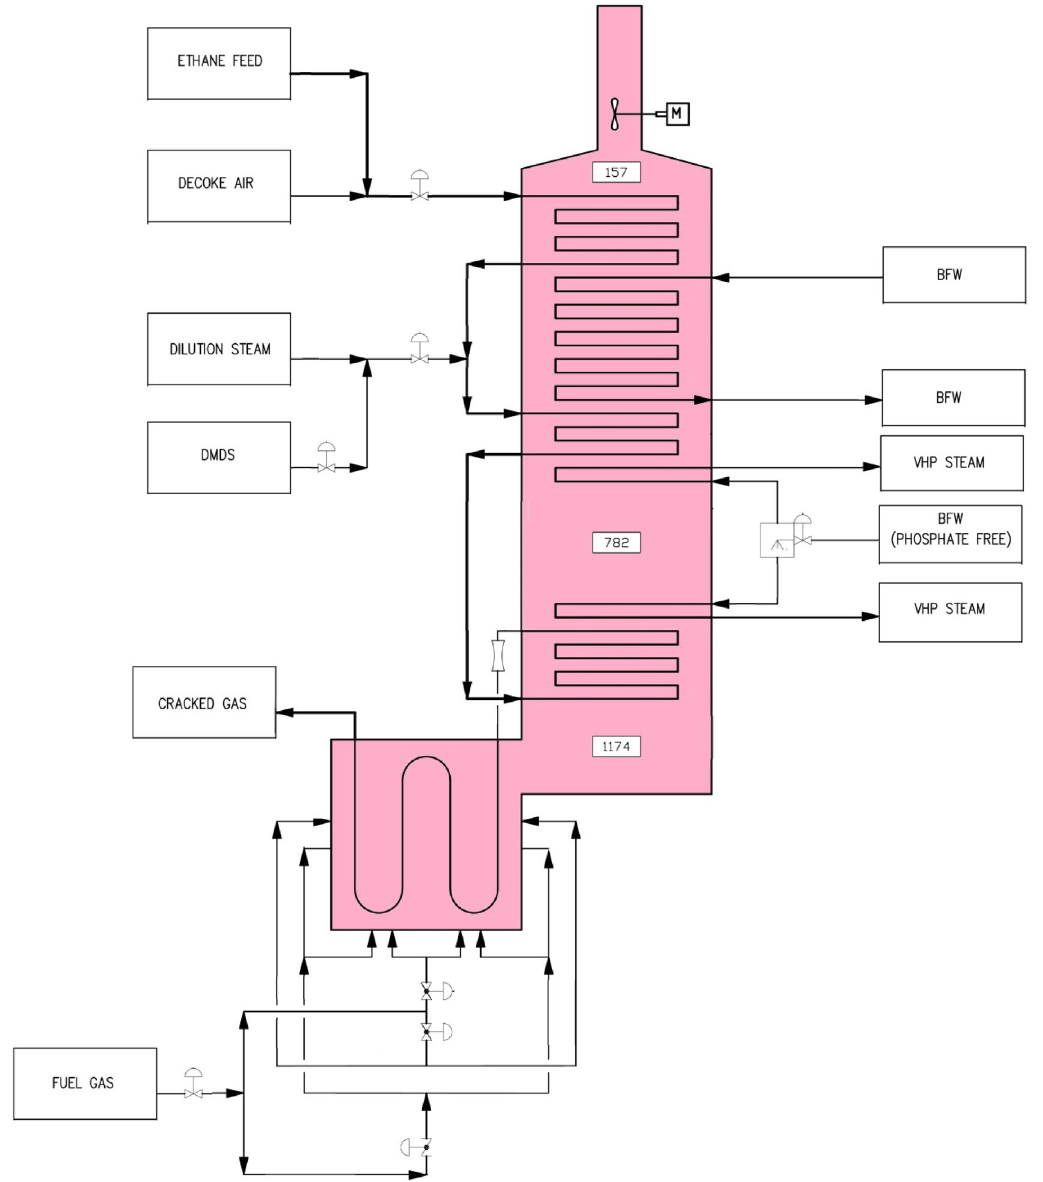
Fig. 1 Schematic representation of ethane cracker furnace for production of self-diffused catalytic